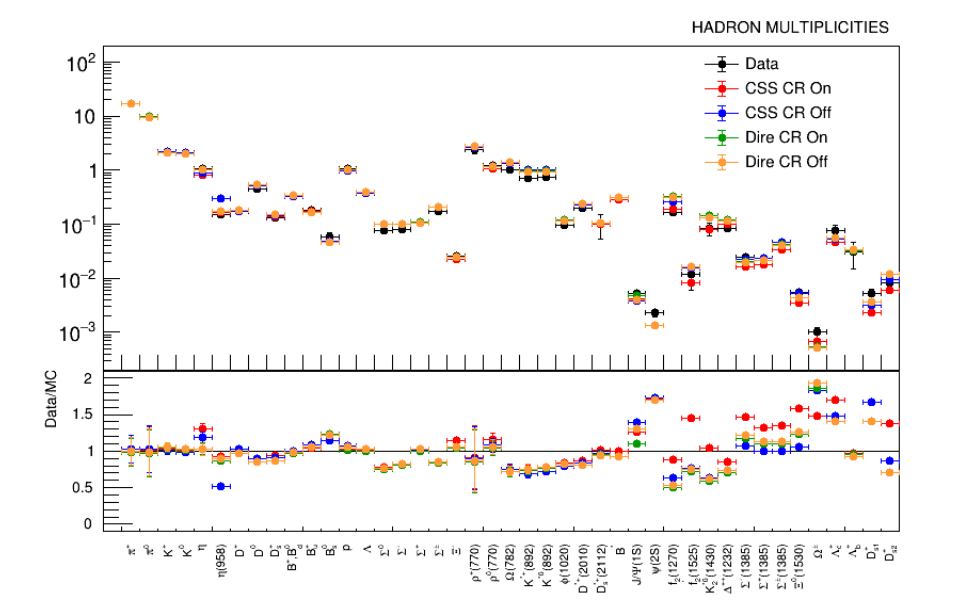
Figure 7: Hadron yields for various species are compared to the data from the particle data group [ 52 ] , and Ω ± is compared to the data from A LEPH [ 53 ]